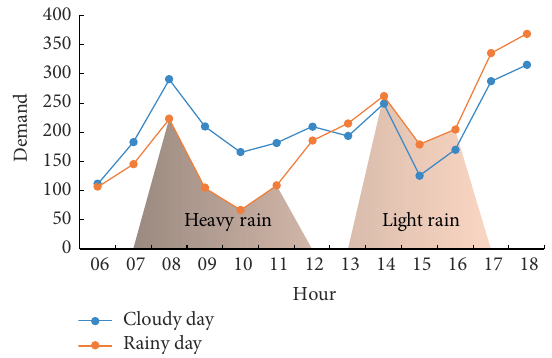
Figure 3: Comparison of different weather conditions for two identical